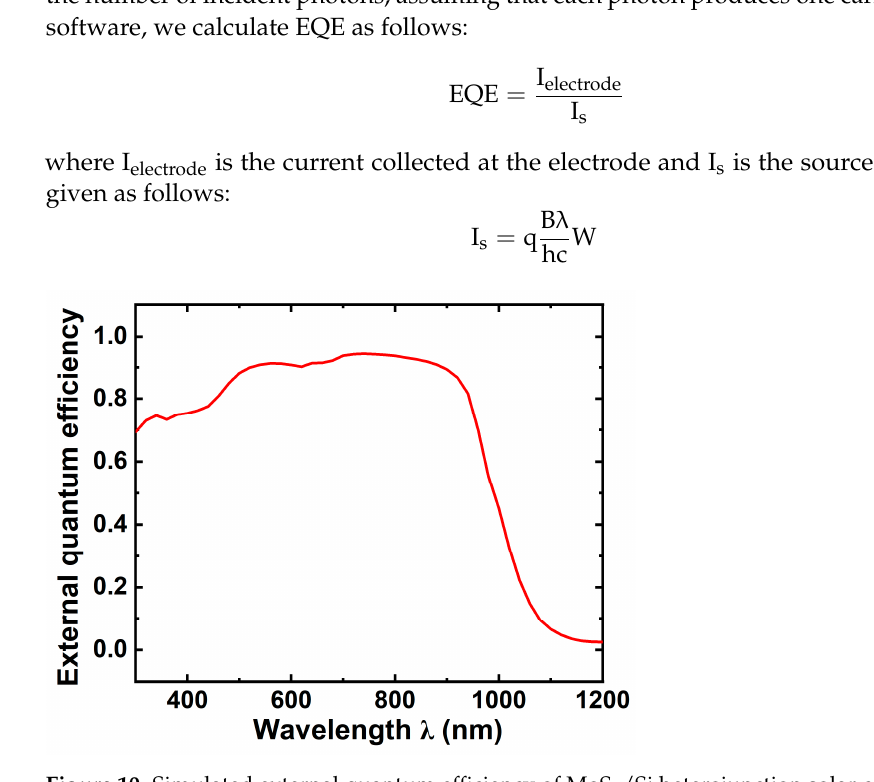
Figure 10. Simulated external quantum efficiency of MoS 2 /Si heterojunction solar cell. Table 2 . Simulation parameters of n-MoS 2 /p-Si heterojunction solar cell.